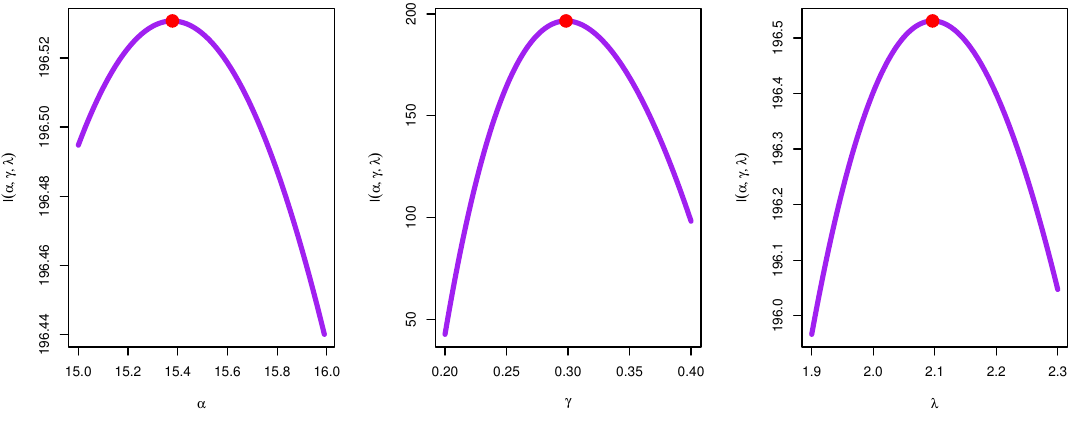
Figure 7. Profile likelihood α , γ , and λ for the COVID-19